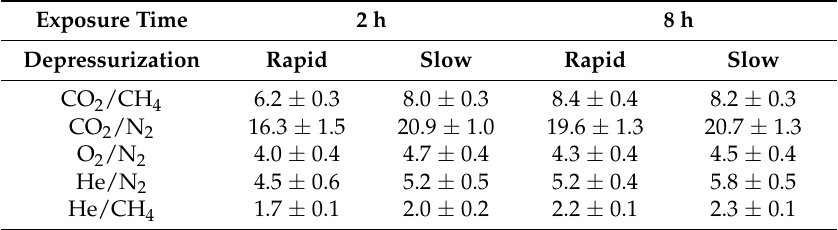
Table 5. Selectivity of supercritical CO 2 -treated PIM-1 membrane at 35 ◦